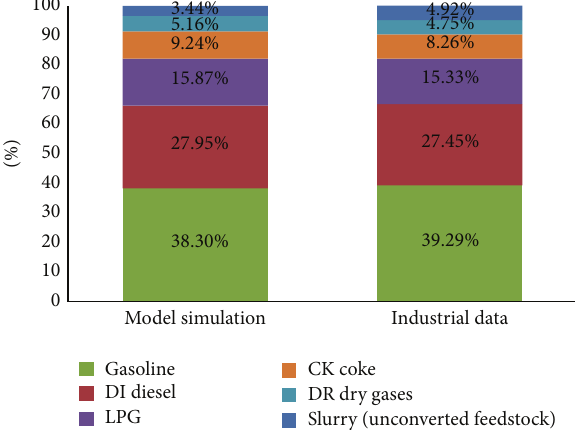
Figure 7: Comparison between industrial data and the simulation model for each